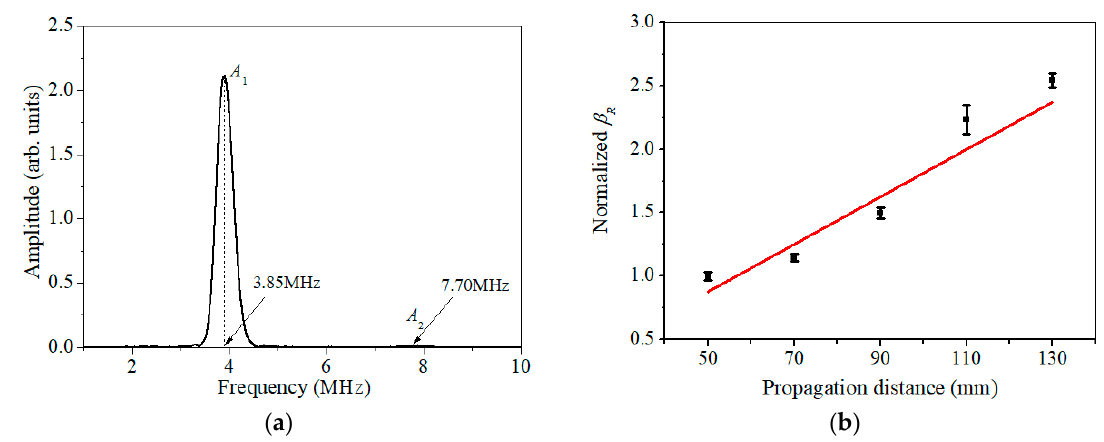
Figure 7. ( a ) Amplitude-frequency curve of the time-domain signal detected at z = 50 mm, ( b ) variation of normalized β R versus propagation distance.